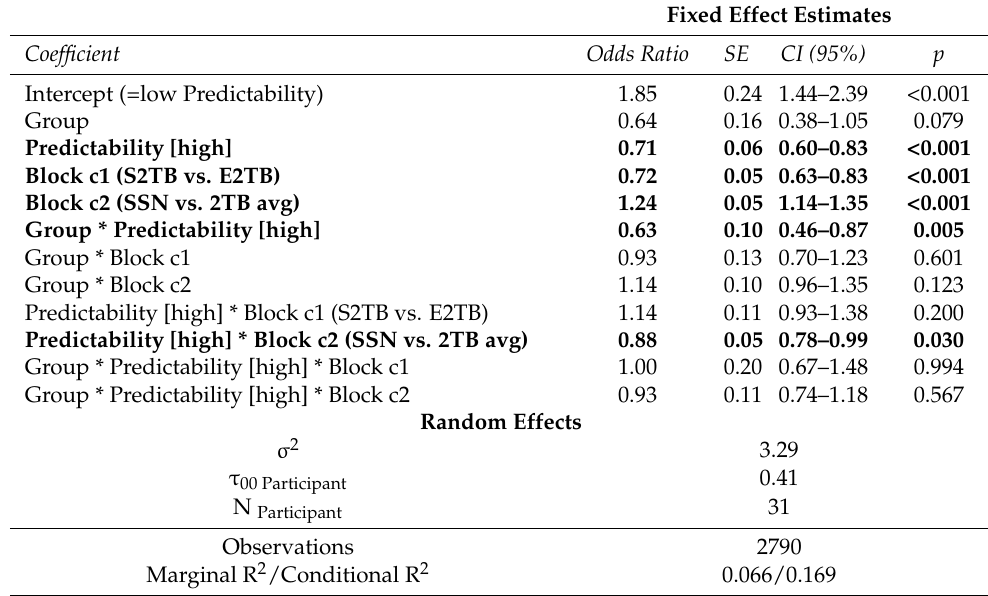
Table 2. Fitted model examining keyword transcription accuracy for the speech-in-noise recognition task.